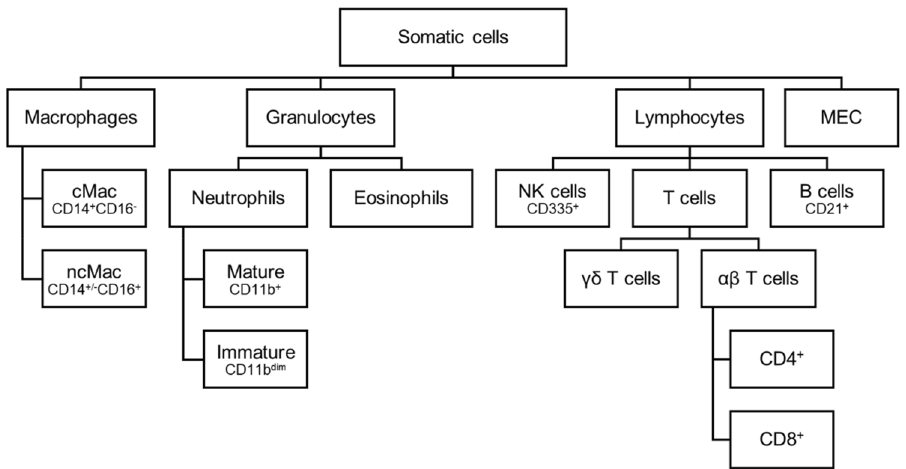
Figure 2. Overview of the detected cell populations in